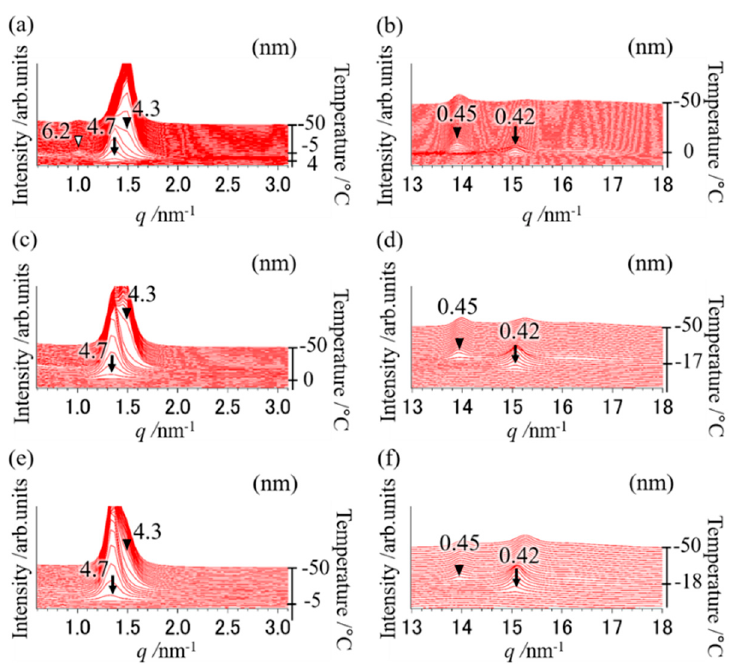
Figure 3. SR-TXRD results at the cooling rate of ( a , b ) 5 ◦ C min − 1 , ( c , d ) 30 ◦ C min − 1 , and ( e , f ) 35 ◦ C min − 1 with a binary mixture of OPO / POP = 4 / 6. The x-axes show q value (q = 4 π · sin ( θ ) / λ ). The left y-axes show di ff raction intensity. The right y-axes show temperature. ( a , c , e ) indicate magnification of small-angle pattern. ( b , d , f ) indicate magnification of wide-angle pattern. The arrows are derived from α -2 POP. The closed triangles are derived from β -2 MC. The open triangle is derived from β -3 OPO. When the DSC cooling thermogram was obtained at a cooling rate of 1 °C min − 1 (Figure 2), we observed two exothermic peaks (black arrow and closed triangle). When the cooling rate was increased to 5 °C min − 1 , both peaks were observed at a lower temperature.